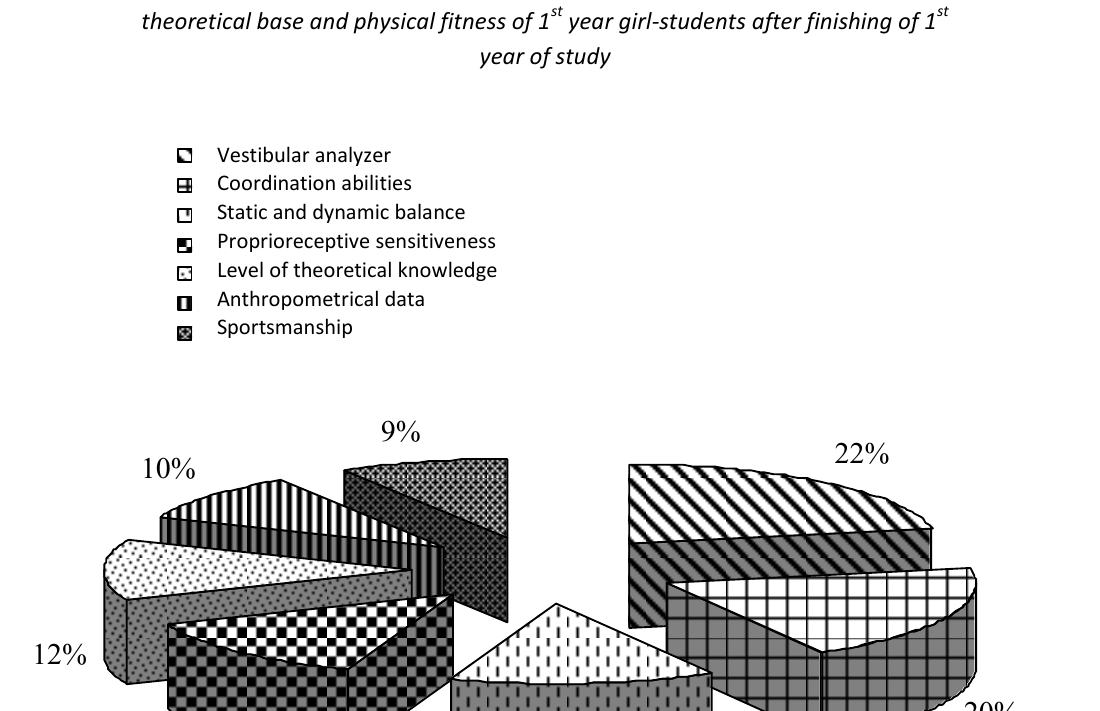
Fig. 3 Correlation of factors, which determine level of sensorimotor coordination,